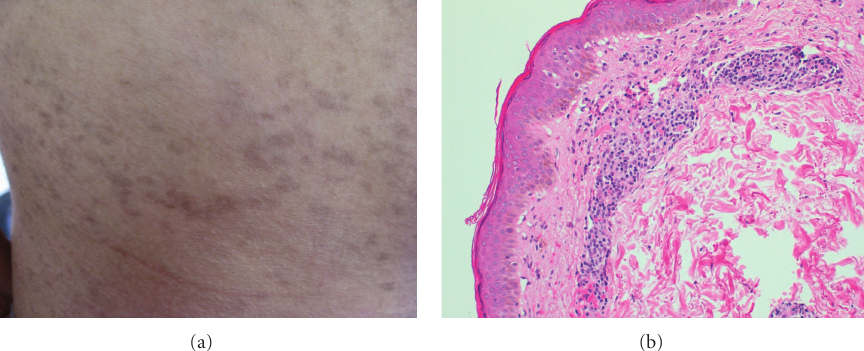
Figure 1: (a) Red-to-brown maculopapules in trunk. (b) Epidermal acanthosisand scanty lymphocytic exocitosis. Perivascular infiltrates of lymphocytes in dermis (haematoxylin and eosin, original magnification ×